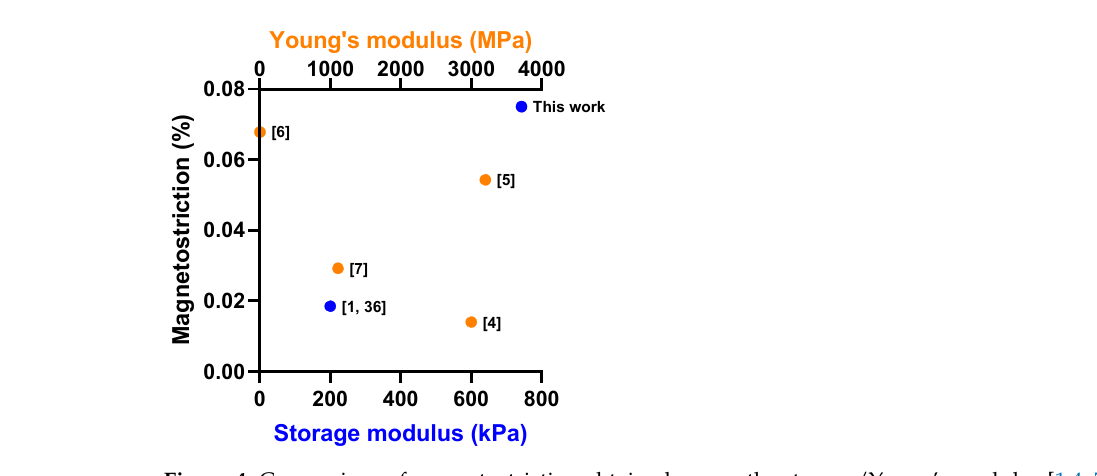
Figure 4. Comparison of magnetostriction obtained versus the storage/Young’s modulus [1,4– 7,36].